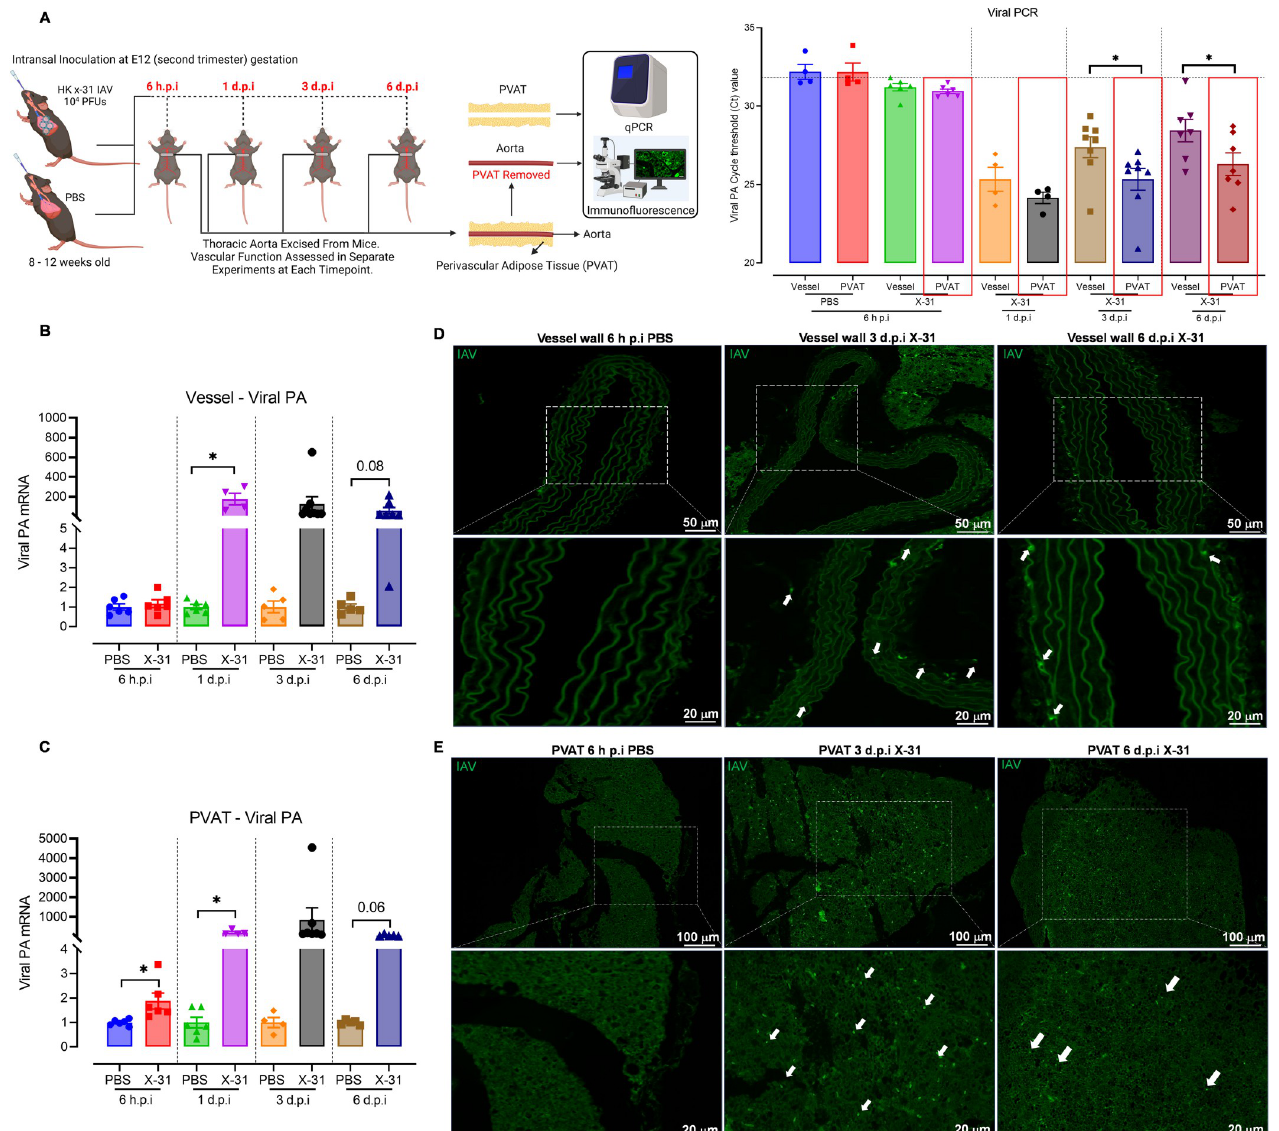
Fig 1. Influenza A virus (IAV) primarily disseminates into the PVAT of pregnant mice compared to the arterial wall. Eight-to-twelve-weeks-old pregnant (E12 gestation) C57BL/6 mice were intranasally inoculated with PBS or Hk-x31 (X-31; 10 4 PFU) for arterial wall and PVAT tissue assessment at 6 hours post infection (h.p.i), 1, 3 and 6 days post infection (d.p.i). (A) Schematic of infection schedule and experiments (created with BioRender.com), the presence of IAV burden in the arterial wall and PVAT was confirmed through qPCR, using a cycle threshold of < 31 cycles as a confirmed infection. (B—C) Vessel wall and PVAT gene expression of viral PA normalized to GAPDH or RPS18. (D) Representative immunofluorescence image of the arterial wall of pregnant PBS and Hk-x31 infected mice at 6 h, or 3 and 6 d.p.i labeled with IAV nucleoprotein antibody (green). (E) Representative immunofluorescence image of the PVAT of pregnant PBS at 6 h.p.i and Hk-x31 infected mice at 6 h, or 3 and 6 d.p.i labeled with IAV nucleoprotein antibody (green). Data are represented as mean ± SEM (pregnant PBS, n = 4–8; pregnant X-31, n = 4–8 of at least two to three independent experiments). All fold change calculations of the X-31 group were measured via qPCR, performed against the PBS group within its respective timepoint and normalised against RPS18 (except otherwise stated). Statistical analysis was performed using unpaired t-test against their respective PBS control. � P < 0.05.